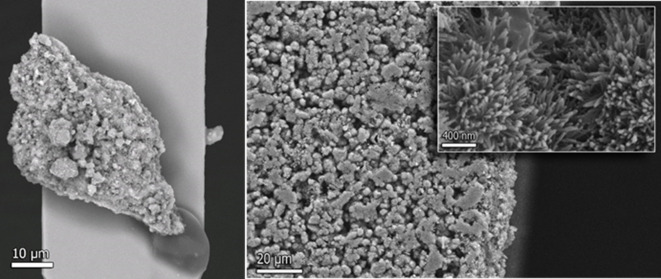
Back‑scattered electron image of an AFM probe and HA surface.